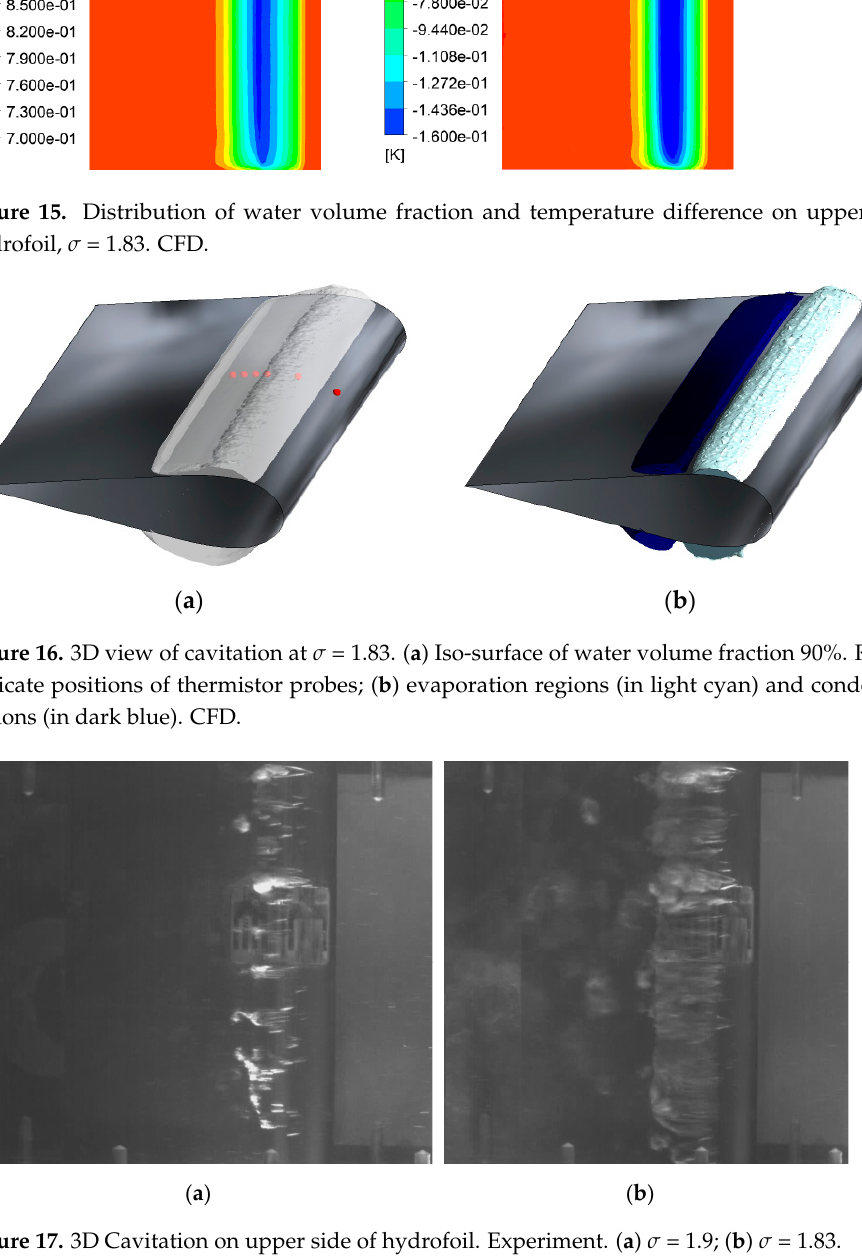
Figure 14. 3D view of c avitation at σ = 1.9. ( a ) Iso-surface of water volume fraction 90%. Red balls indicate positions of thermistor probes; ( b ) evaporation regions (in light cyan) and condensation regions (in dark blue). CFD.